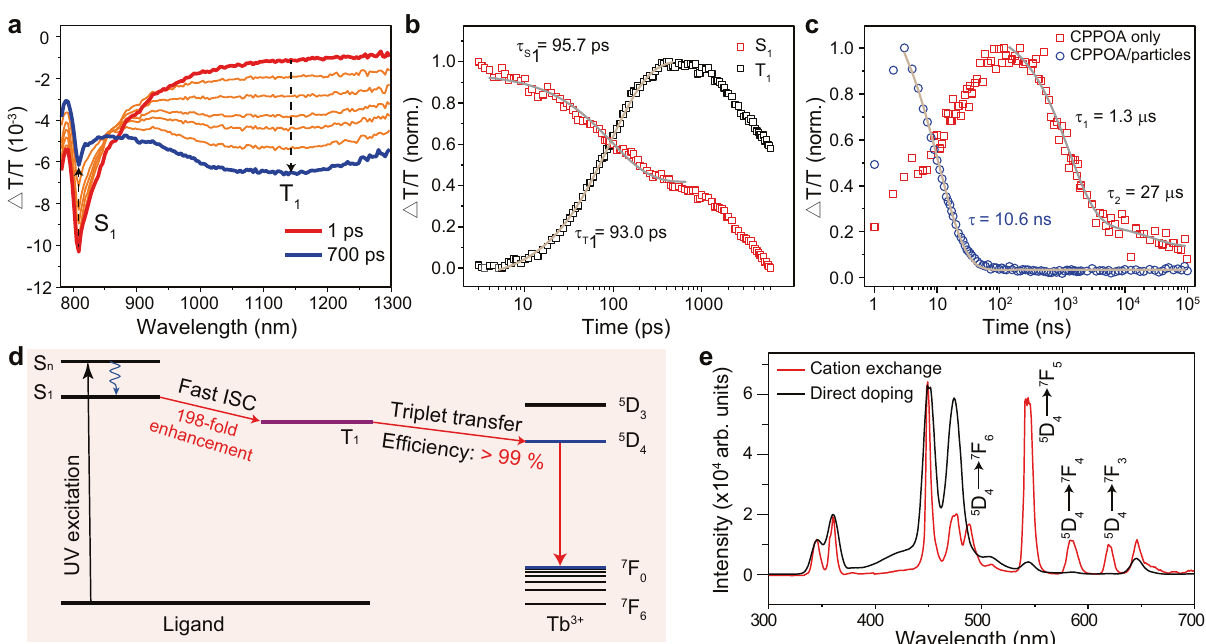
Fig. 3 Investigation of energy transfer from ligands to surface emitters. a Femtosecond transient absorption spectra of CPPOA-modi fi ed NaYF 4 @NaYbF 4 :1%Tm@NaYF 4 :Tb nanoparticles obtained by cation exchange. The excitation wavelength is 345 nm with the pulse energy of 2 μ J. Note that the upward and downward arrows refer to singlet-decay and triplet-rise trends over delay time, respectively. b Kinetics of singlet (S 1 ) decay and triplet (T 1 ) rise, obtained from picosecond transient absorption of the CPPOA-modi fi ed nanoparticle solution. c Kinetics of triplet decay obtained from nanosecond transient absorption spectra of the CPPOA and CPPOA-modi fi ed nanoparticle solution. d Simpli fi ed energy diagram showing an ultrafast intersystem crossing in CPPOA molecules and triplet energy transfer to Tb 3 + emitters. e Upconversion luminescence spectra of CPPOA-modi fi ed NaYF 4 @NaYbF 4 :1%Tm@NaYF 4 :Tb nanoparticles obtained by cation exchange with TbCl 3 (red) and by direct Tb 3 + -doping (black) under 980-nm